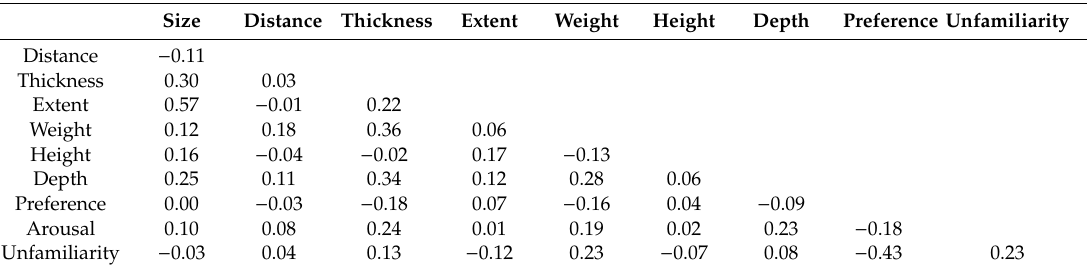
Table 1. Correlation matrix among all adjective evaluations.